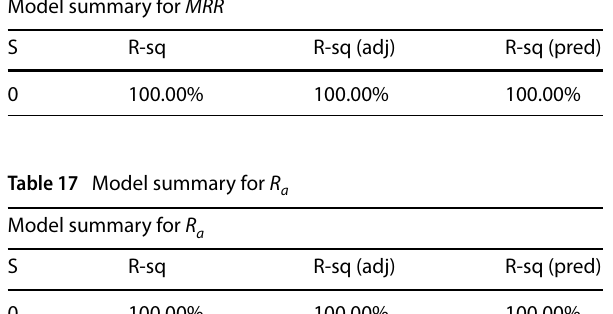
Table 16 Model Summary for MRR Model summary for MRR